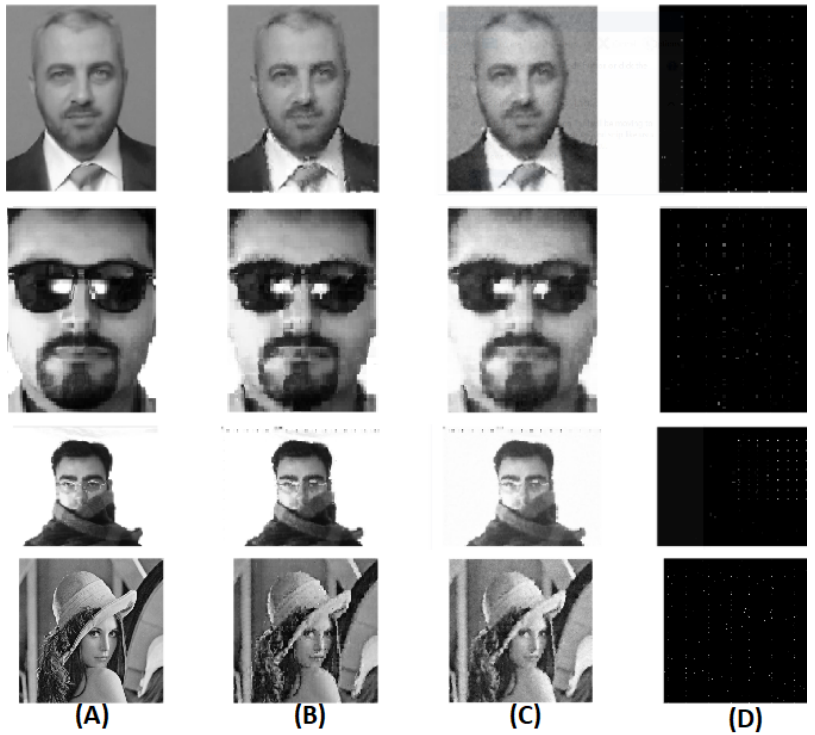
Figure 9. A visual sample for image restoration: ( A ) Original image, ( B ) Restored image, ( C ) Filtered restored image, and ( D ) Coded Chimera